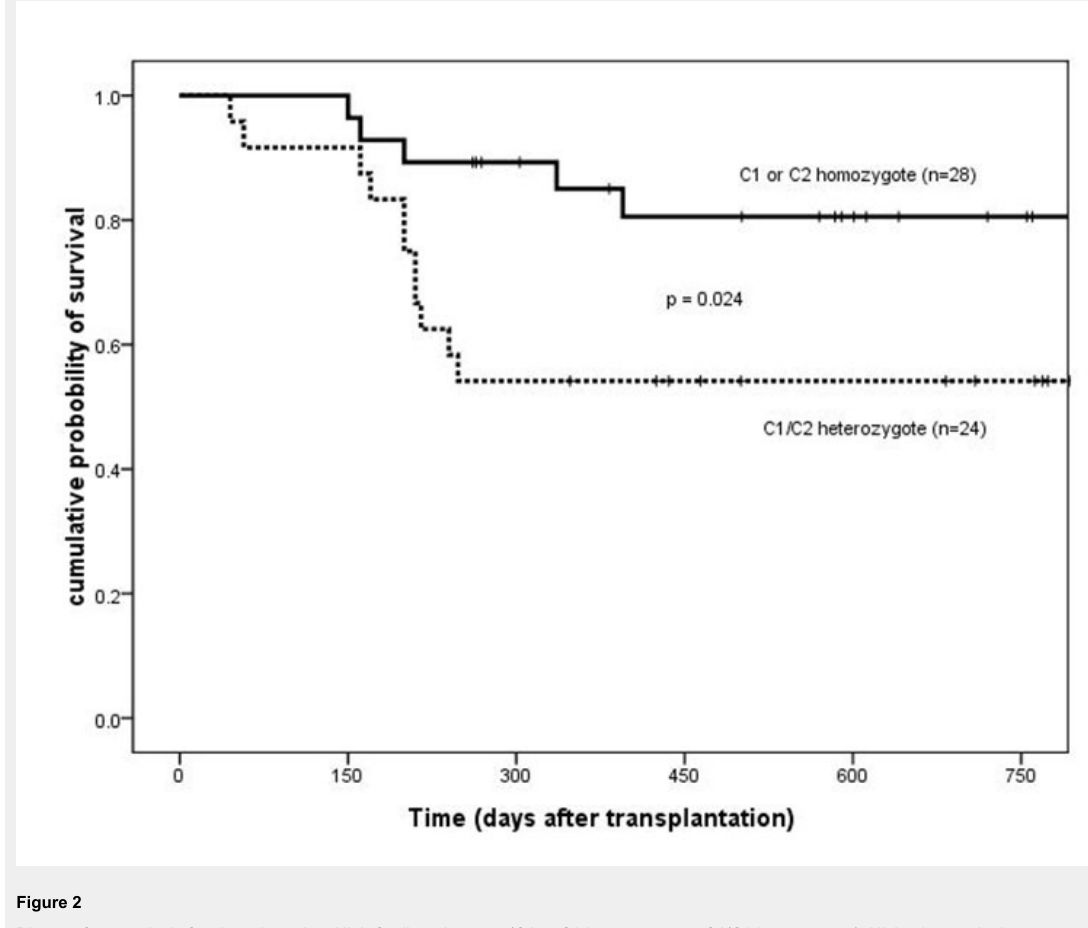
Figure 2 Disease-free survival of patients based on HLA-Cw ligand groups (C1 or C2 homozygote vs C1/C2 heterozygote). HLA = human leukocyte